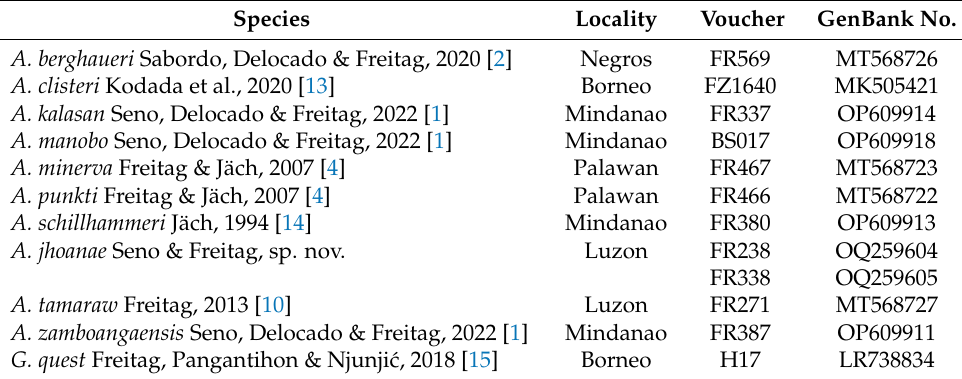
Table 1. GenBank accession numbers and specimen geographical origins of Ancyronyx and Grouvellinus sequences used in the COI sequence